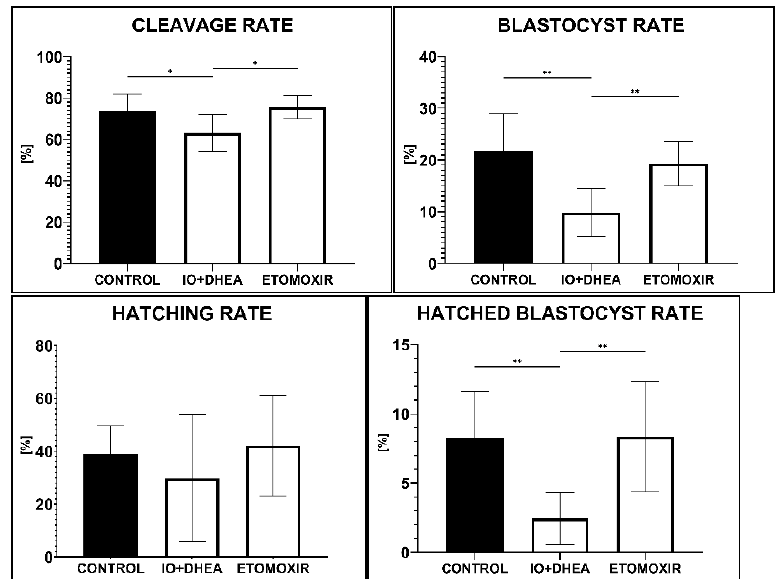
Figure 1. The effect of glucose (IO+DHEA) and fatty acid (ETOMOXIR) metabolism inhibition on the efficiency of in vitro embryo production (means ± SD). * — p ≤ 0.05, ** — p ≤ 0.01.